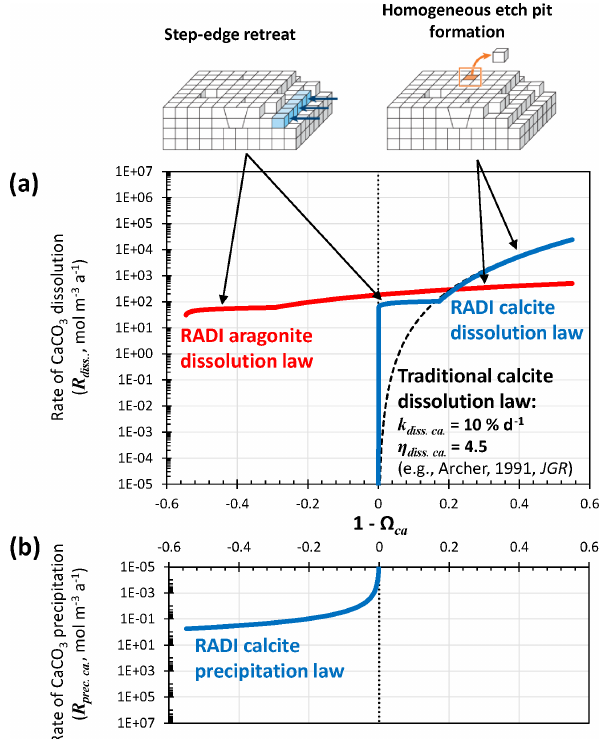
Figure 2. (a) Dissolution rate of calcite as computed using Eq. (12) and [ Calcite ] = 10 4 molm − 3 (solid blue line), and dissolution rate of aragonite as computed using Eq. (13) and [ Aragonite ] = 10 4 molm − 3 (solid red line). Note that for each dissolution rate pro- file, two different rate constants ( k diss ) and reaction orders ( η diss ) are used, depending on the seawater saturation state, with each ac- counting for a separate dissolution mechanism, i.e., step-edge re- treat or homogeneous-edge pit formation. The dashed black line stands for a “traditional” dissolution rate profile obtained using [ Calcite ] = 10 4 molm − 3 , a single dissolution rate constant for the entire (1 − (cid:127) ca ) range k diss = 10%d − 1 , and a reaction order η diss of 4.5. (b) Precipitation rate of calcite as computed from Eq. (14). Note that dissolution rates are normalized here per total solid sed- iment volume and not per CaCO 3 surface area as in traditional ki- netics